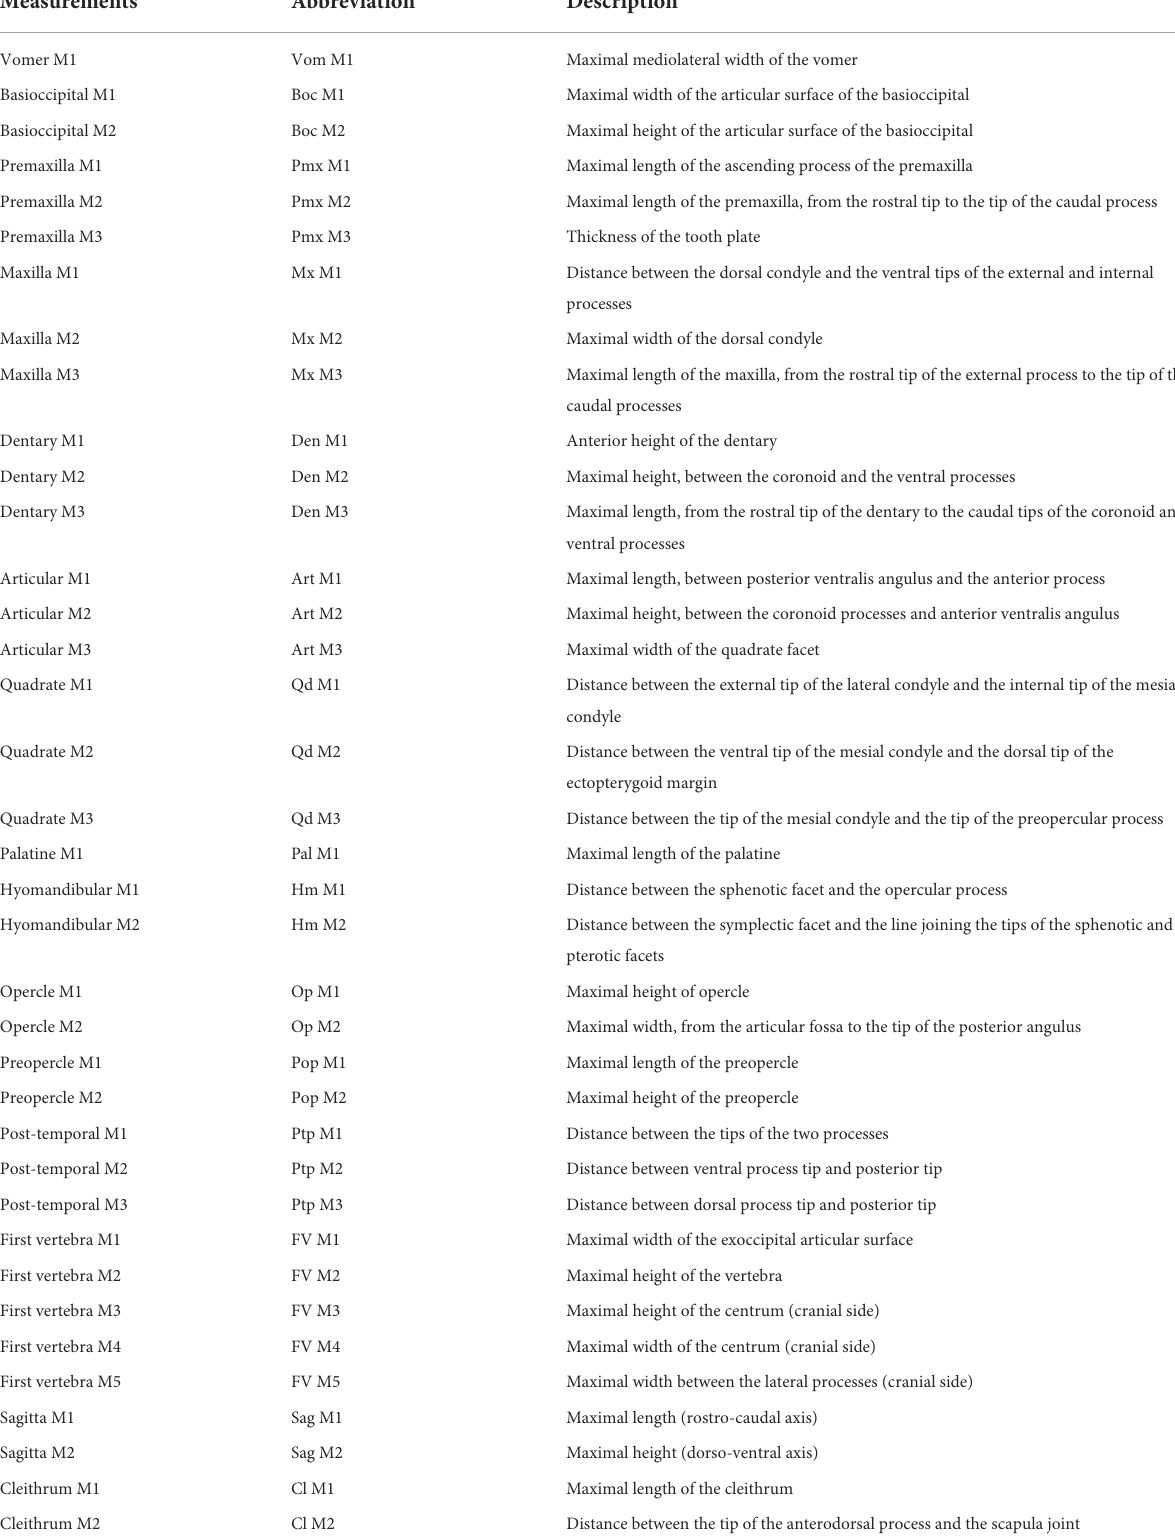
TABLE 2 Descriptions of the bone measurements taken from Chinese sea bass ( Lateolabrax maculatus )